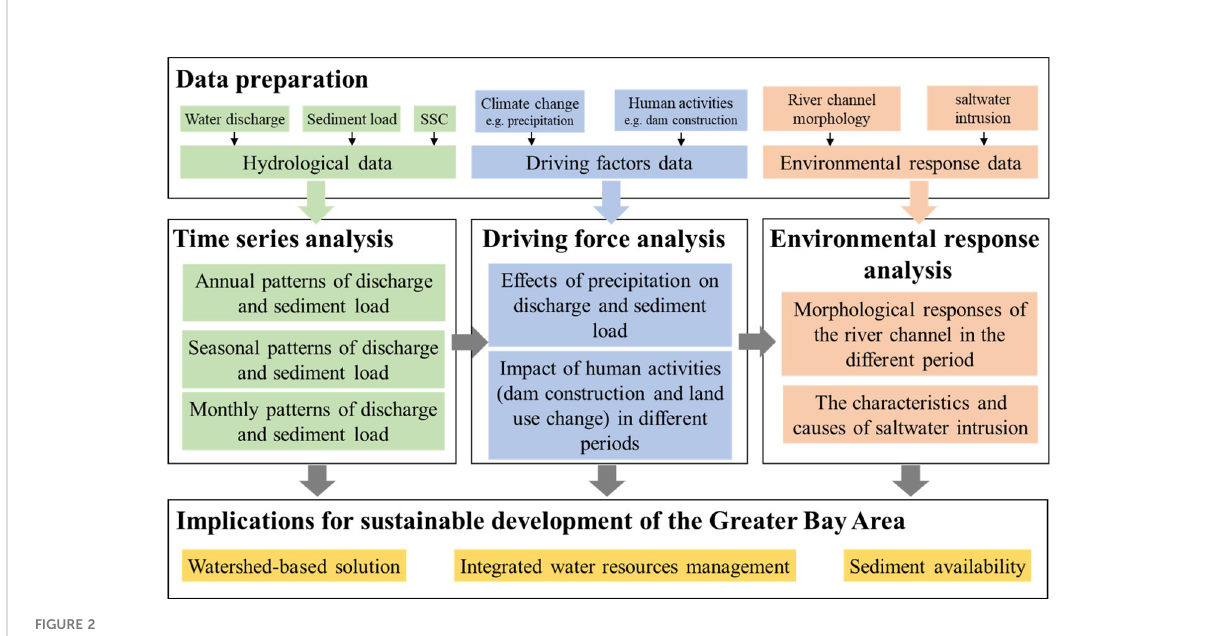
FIGURE 2 Flow chart of this study. SSC denotes suspended sediment